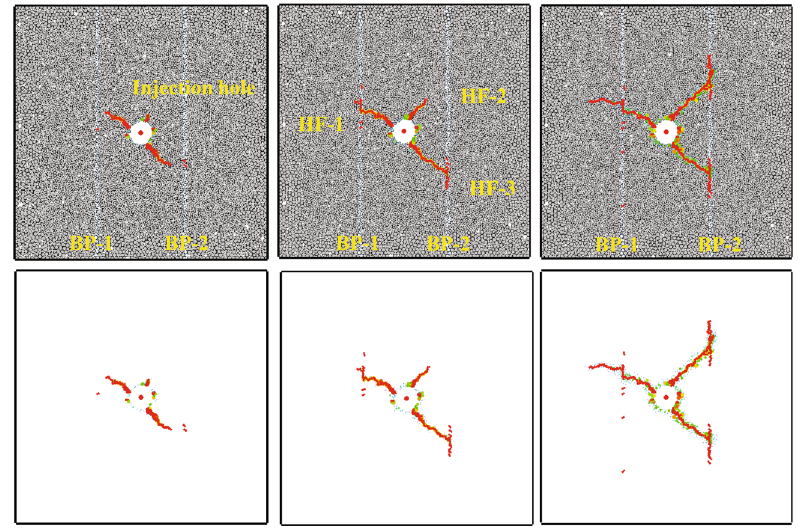
Figure 15: Group 2-2 hydraulic fracture morphology and interactive penetration